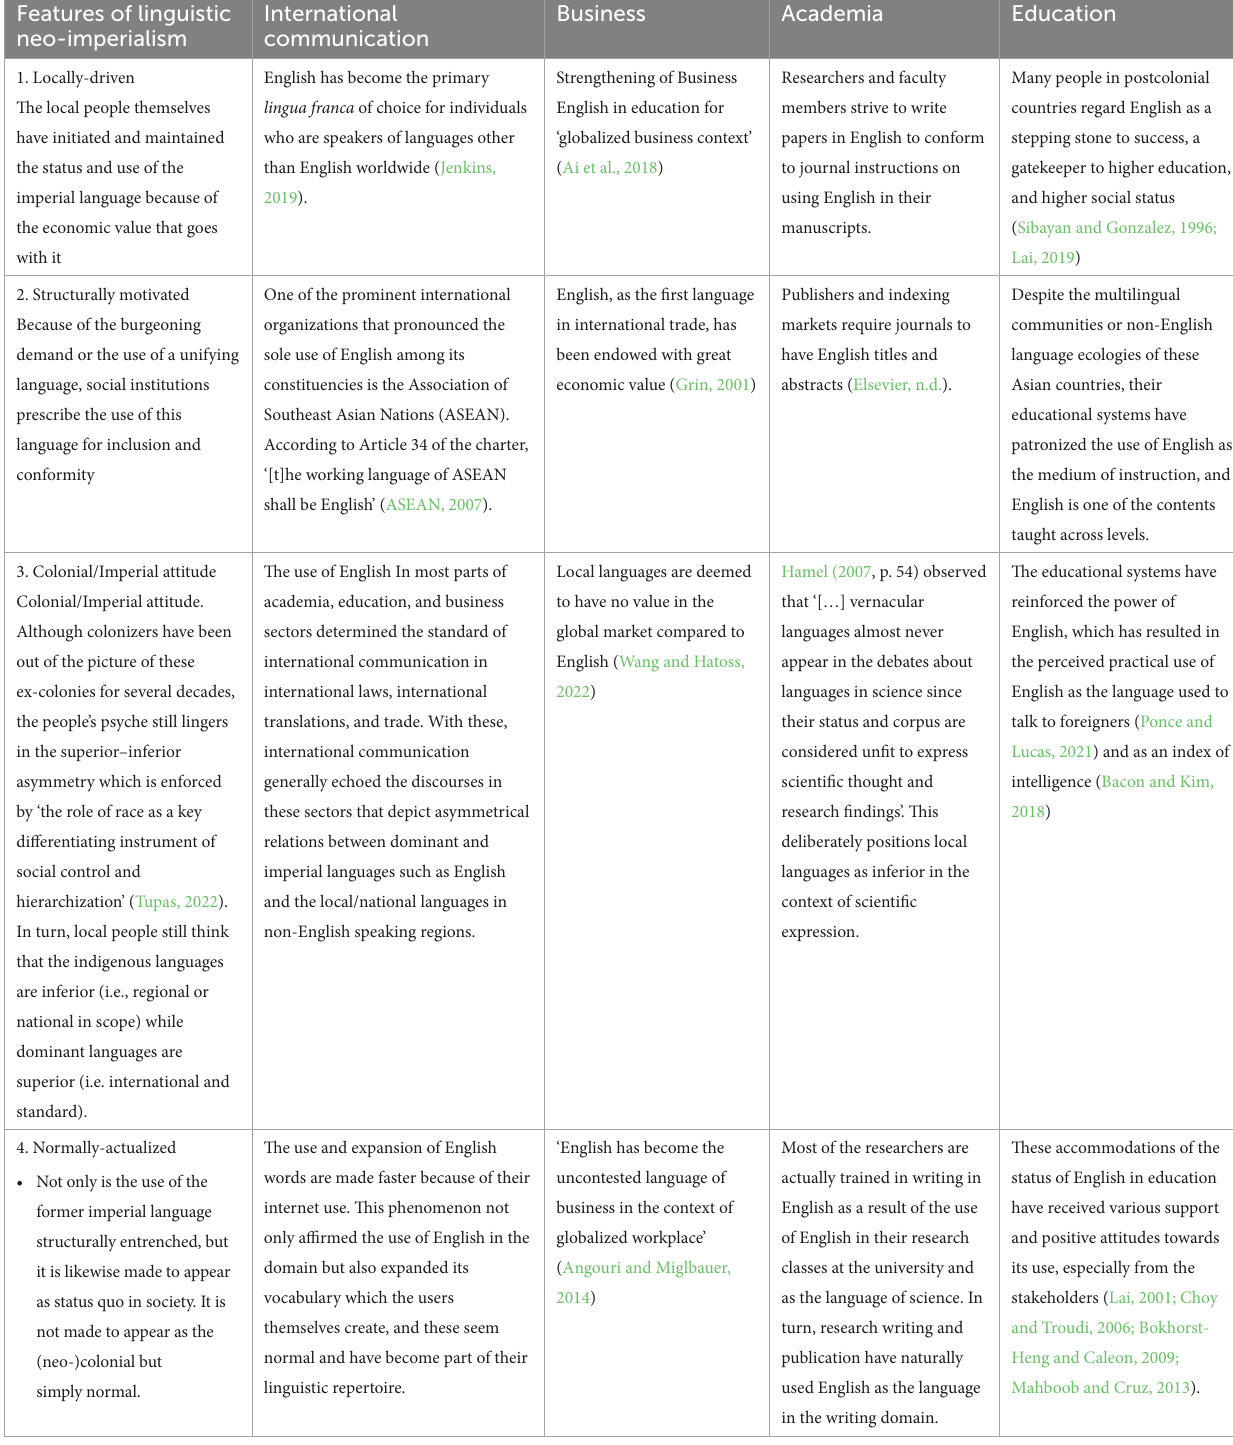
TABLE 1 Summary of the Features of English linguistic neo-imperialism and its exemplifications in the major